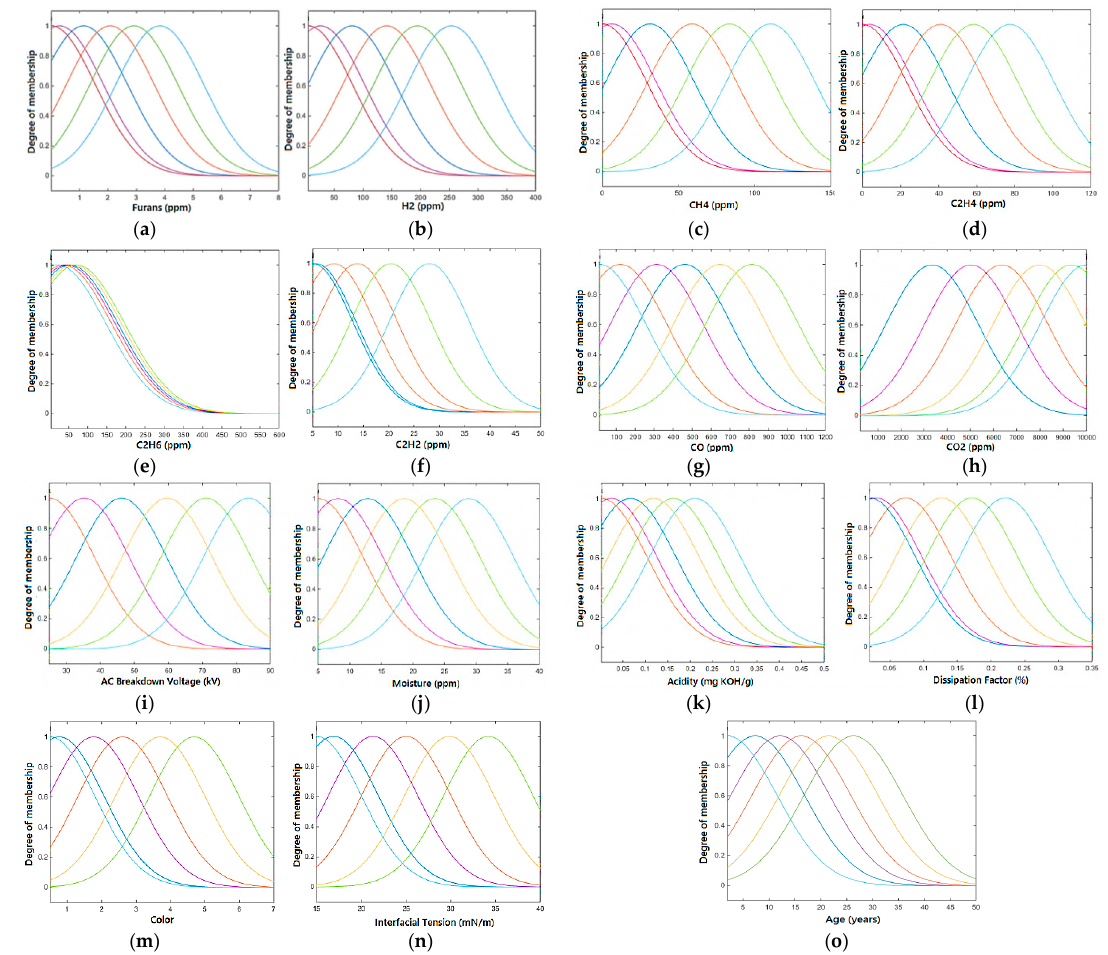
Figure 5. Membership functions of ( a ) furans; ( b ) H 2 ; ( c ) CH 4 ; ( d ) C 2 H 4 ; ( e ) C 2 H 6 ; ( f ) C 2 H 2 ; ( g ) CO; ( h ) CO 2 ; ( i ) ACBDV; ( j ) moisture; ( k ) acidity; ( l ) DF; ( m ) color; ( n ) IFT and ( o ) age for training based on MCS data.